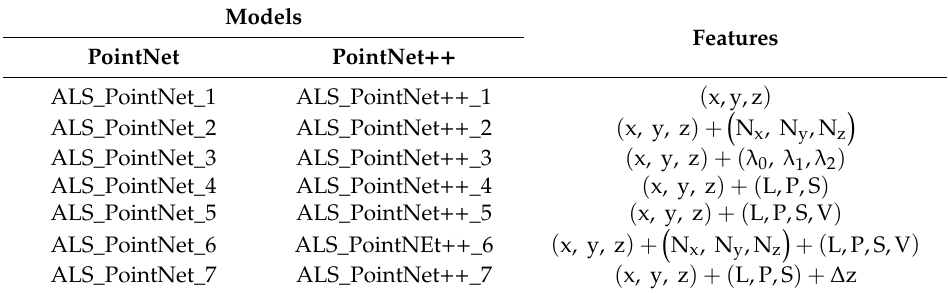
Table 4. PointNet and PointNet++ models with different features for ALS point cloud classification.